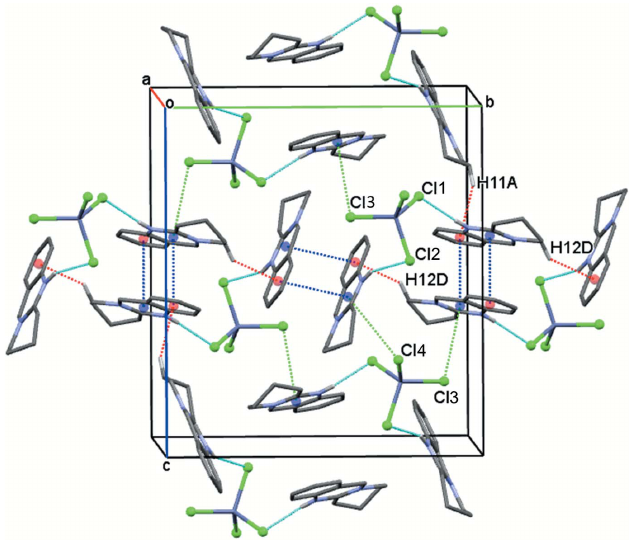
Figure 4 Crystal packing and short contacts in the title compound. Colour code: N—H (cid:2)(cid:2)(cid:2) Cl interactions light-blue dashed lines, intermolecular C—H (cid:2)(cid:2)(cid:2) (cid:2) contacts red dashed lines, Zn—Cl (cid:2)(cid:2)(cid:2) (cid:2) contacts green dashed lines, (cid:2) - (cid:2) stacking interactions dark-blue dashed lines. Centroid for the pyrimidine ( Cg 1, Cg 7) and benzene rings ( Cg 3, Cg 9) are shown as blue and red spheres, respectively.